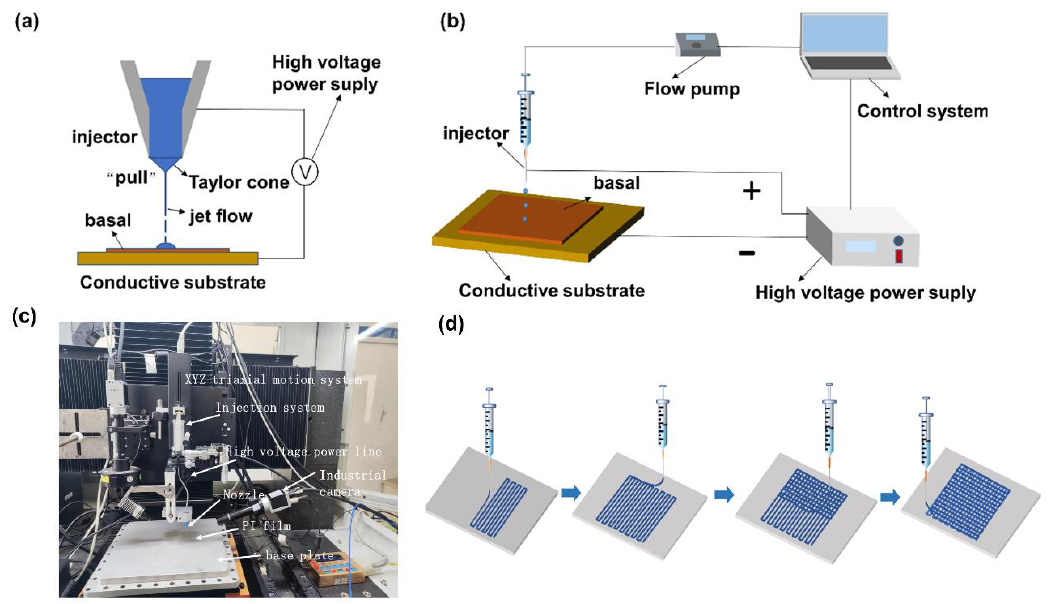
Figure 2. The NFEP process of the PMR nanocomposite thin film. ( a ) The printing principle of the NFEP technology. ( b ) The composition of the self-developed NFEP equipment. ( c ) Physical picture of the NFEP equipment. ( d ) Printing path of the PMR nanocomposite thin film.